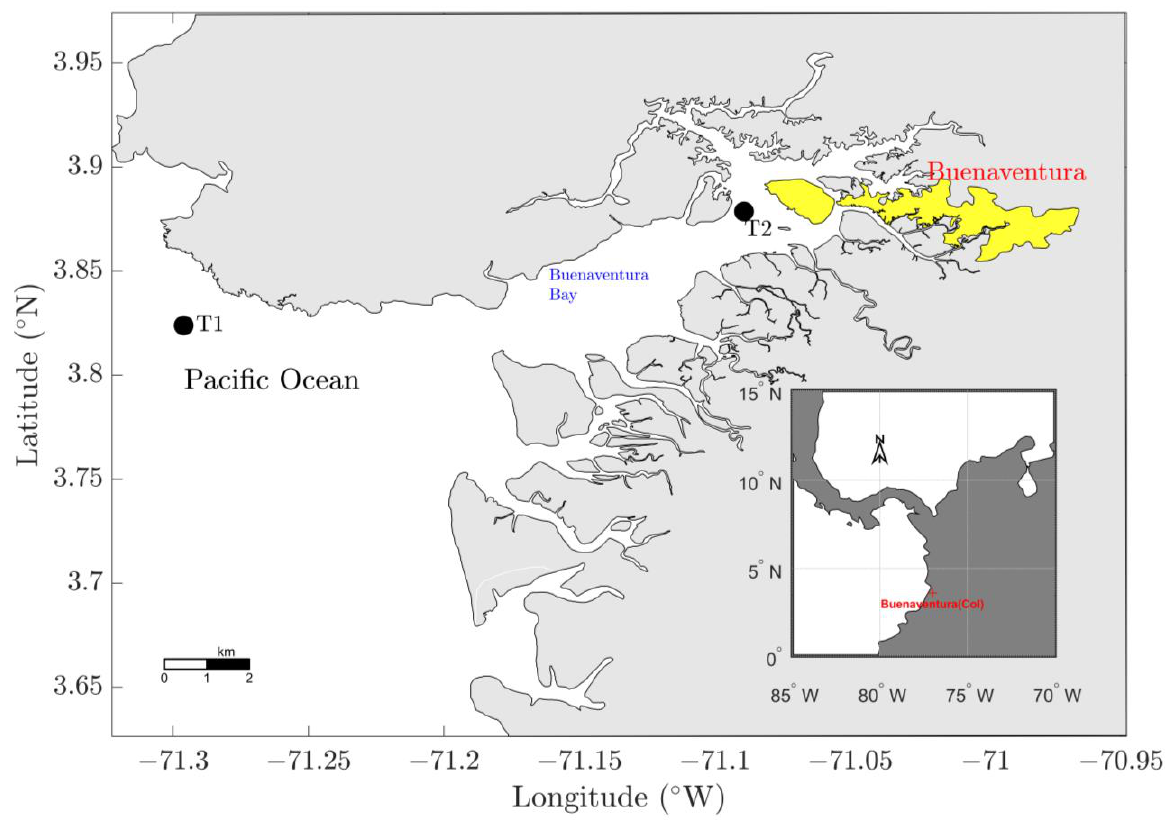
Figure 1. Buenaventura Bay localization.